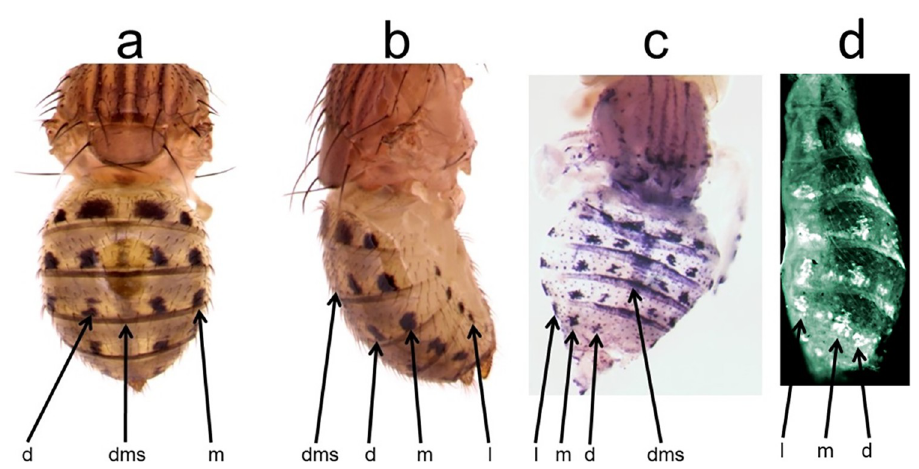
Fig 1. The y gene expression pattern prefigures the adult pigment pattern of D . guttifera . a, Adult, dorsal view showing the dorsal midline shade and the dorsal and median spot rows. b, Adult, lateral view. All three spot rows are visible along with the dorsal midline shade c, yellow mRNA expression pattern in a pupal abdomen at stage P10 showing three pairs of longitudinal spots and a dorsal midline shade. d, Yellow protein expression pattern in a P11 pupal abdomen. dms = dorsal midline shade, d = dorsal, m = median, l = lateral spot